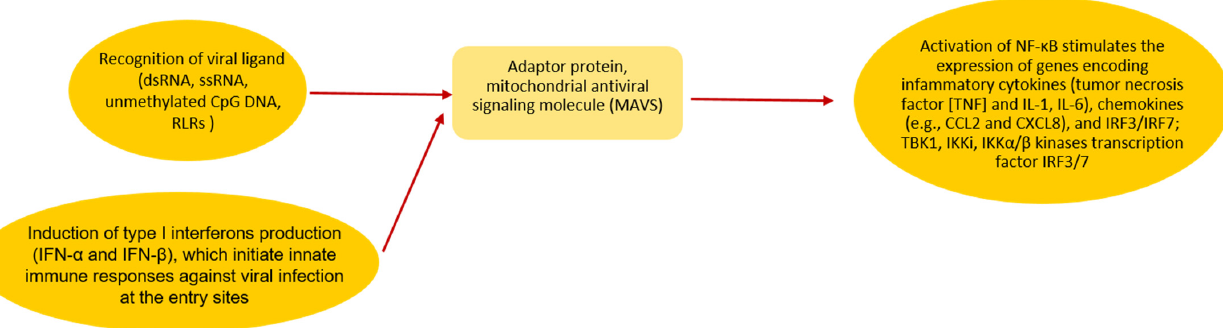
Figure 1. During SARS-CoV-2 invasion in children and adults, the virus and the host cell fuse their membranes mediated by an interaction between the coronaviral S protein and ACE2 receptor on the host cells followed by releasing its RNA into the cytosol [28]. Activation of RIG-I or MDA-5 starts signaling through an adaptor protein, mitochondrial antiviral signaling molecule (MAVS) [28]. It subsequently stimulates the activation of TBK1, Ikki, IKK α / β kinases and transcription factor IRF3/7 and NF- κ B. The next step is IFNs expression and interferon-stimulated genes (ISGs) expression and the expression of inflammatory cytokines [23].